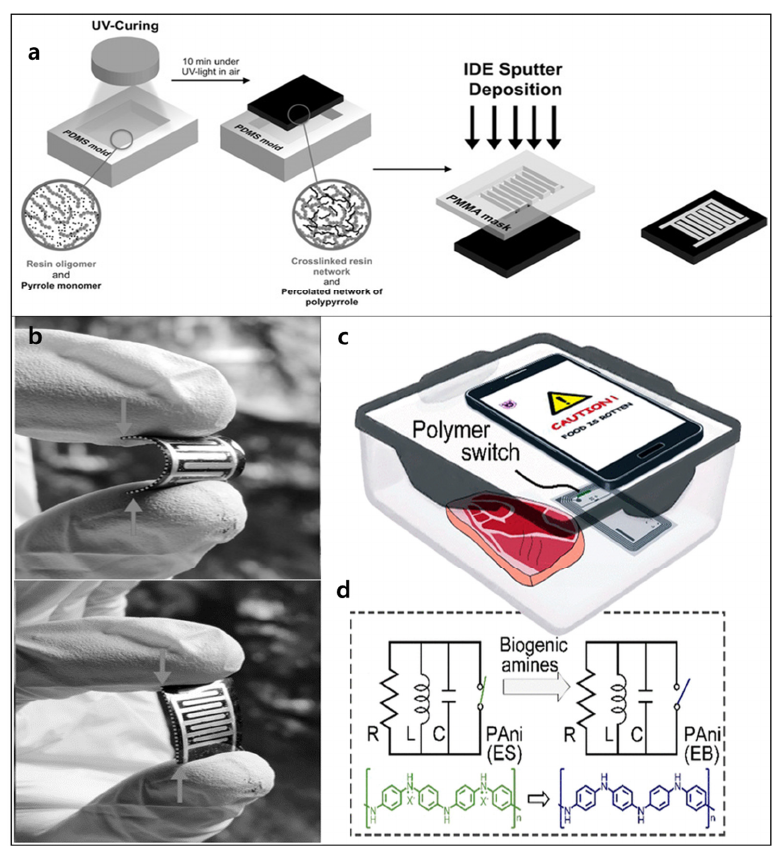
Figure 4. ( a ) Schematic of UV light fabricating process and ( b ) image of a flexible PPy humidity sensor (Reproduced with permission from reference [178]). ( c ) The wireless badge for food spoilage detection based on PANI thin film and ( d ) the circuit of the modified NFC tag for detection of gases released from spoiled meat (Reproduced with permission from reference [183]).